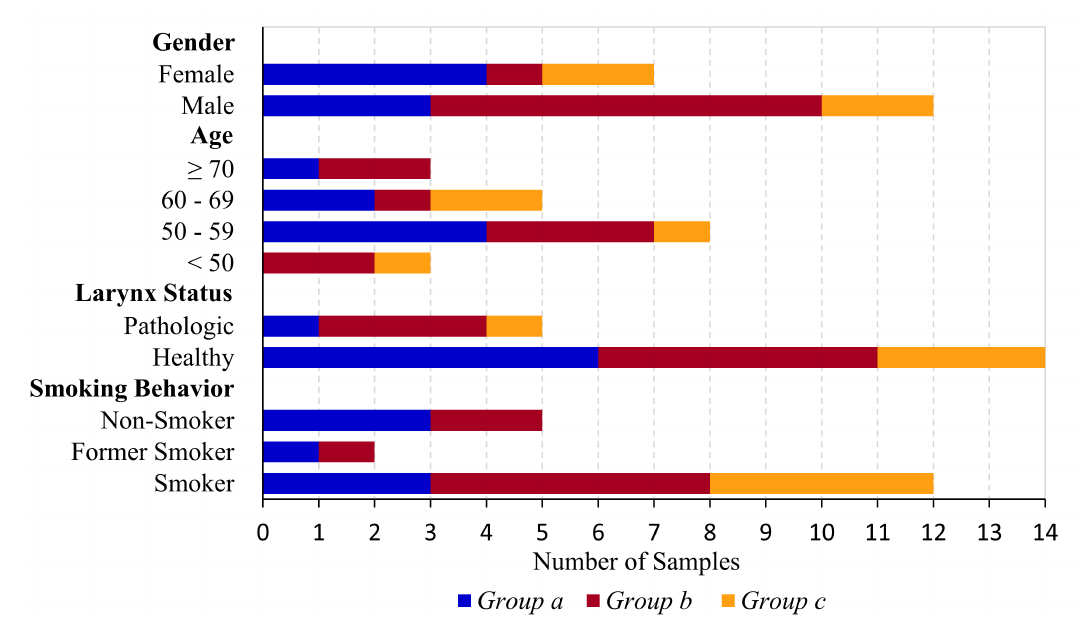
Figure 4. Relationship of the demographic data of the patients to the mucus groups. All groups were found for different gender and larynx status. Whereas group a and group b mucus samples were found for all ages and all smoking behaviors, group c mucus samples were only found for smokers and patients <70 years.